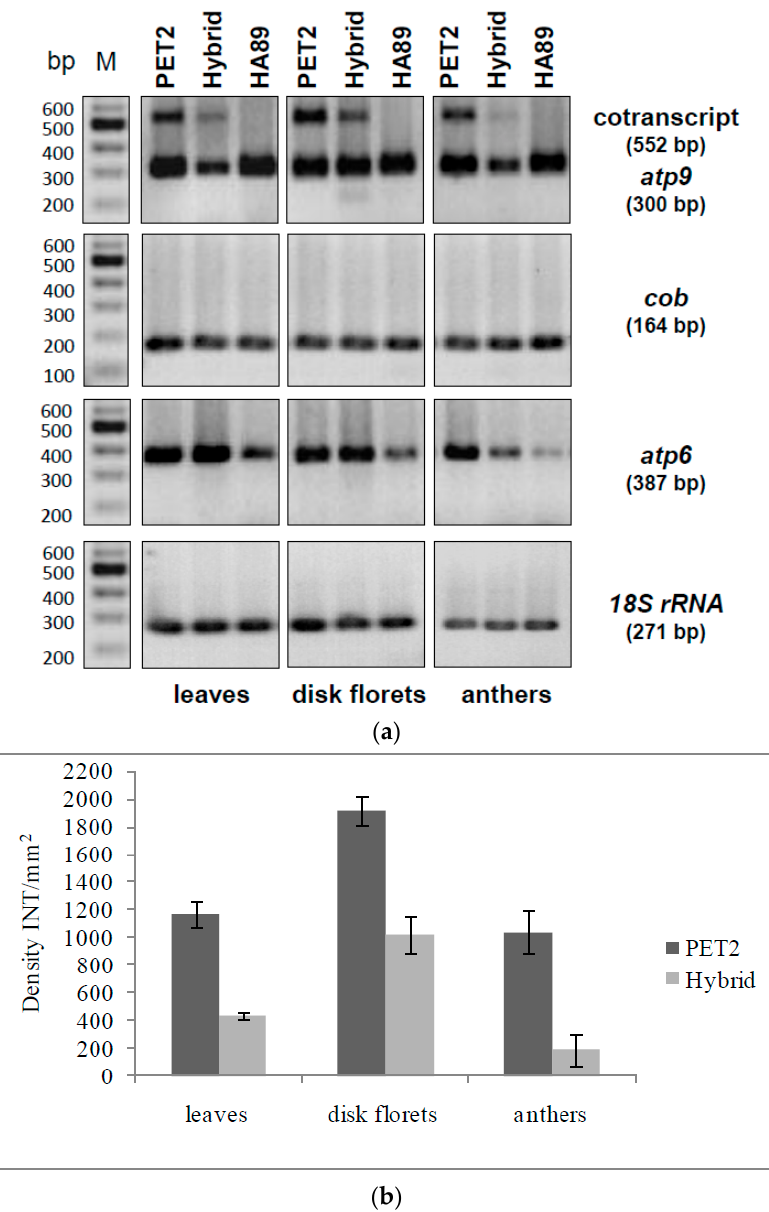
Figure 7. RT-PCR analysis of CMS PET2, the fertility-restored hybrid and the male-fertile line HA89 ( a ) PCR amplification products using primer specific for atp9 ( orf300 ), cob ( orf1194 ), atp6 ( orf1056 ) and 18S rRNA . Expected fragment sizes are given in brackets. Lanes: 1, CMS PET2 (male sterile); 2, PET2 × IH-51 (fertile F1-hybrid); 3, HA89 (fertile, normal cytoplasm); M, 100 bp marker; ( b ) Quantification of the co-transcript expression level (552 bp) in CMS PET2 and the fertility-restored hybrid in leaves, disk florets and anthers by densitometry. Dark grey: CMS PET2, light grey: fertility-restored hybrid (CMS PET2 × IH-51).